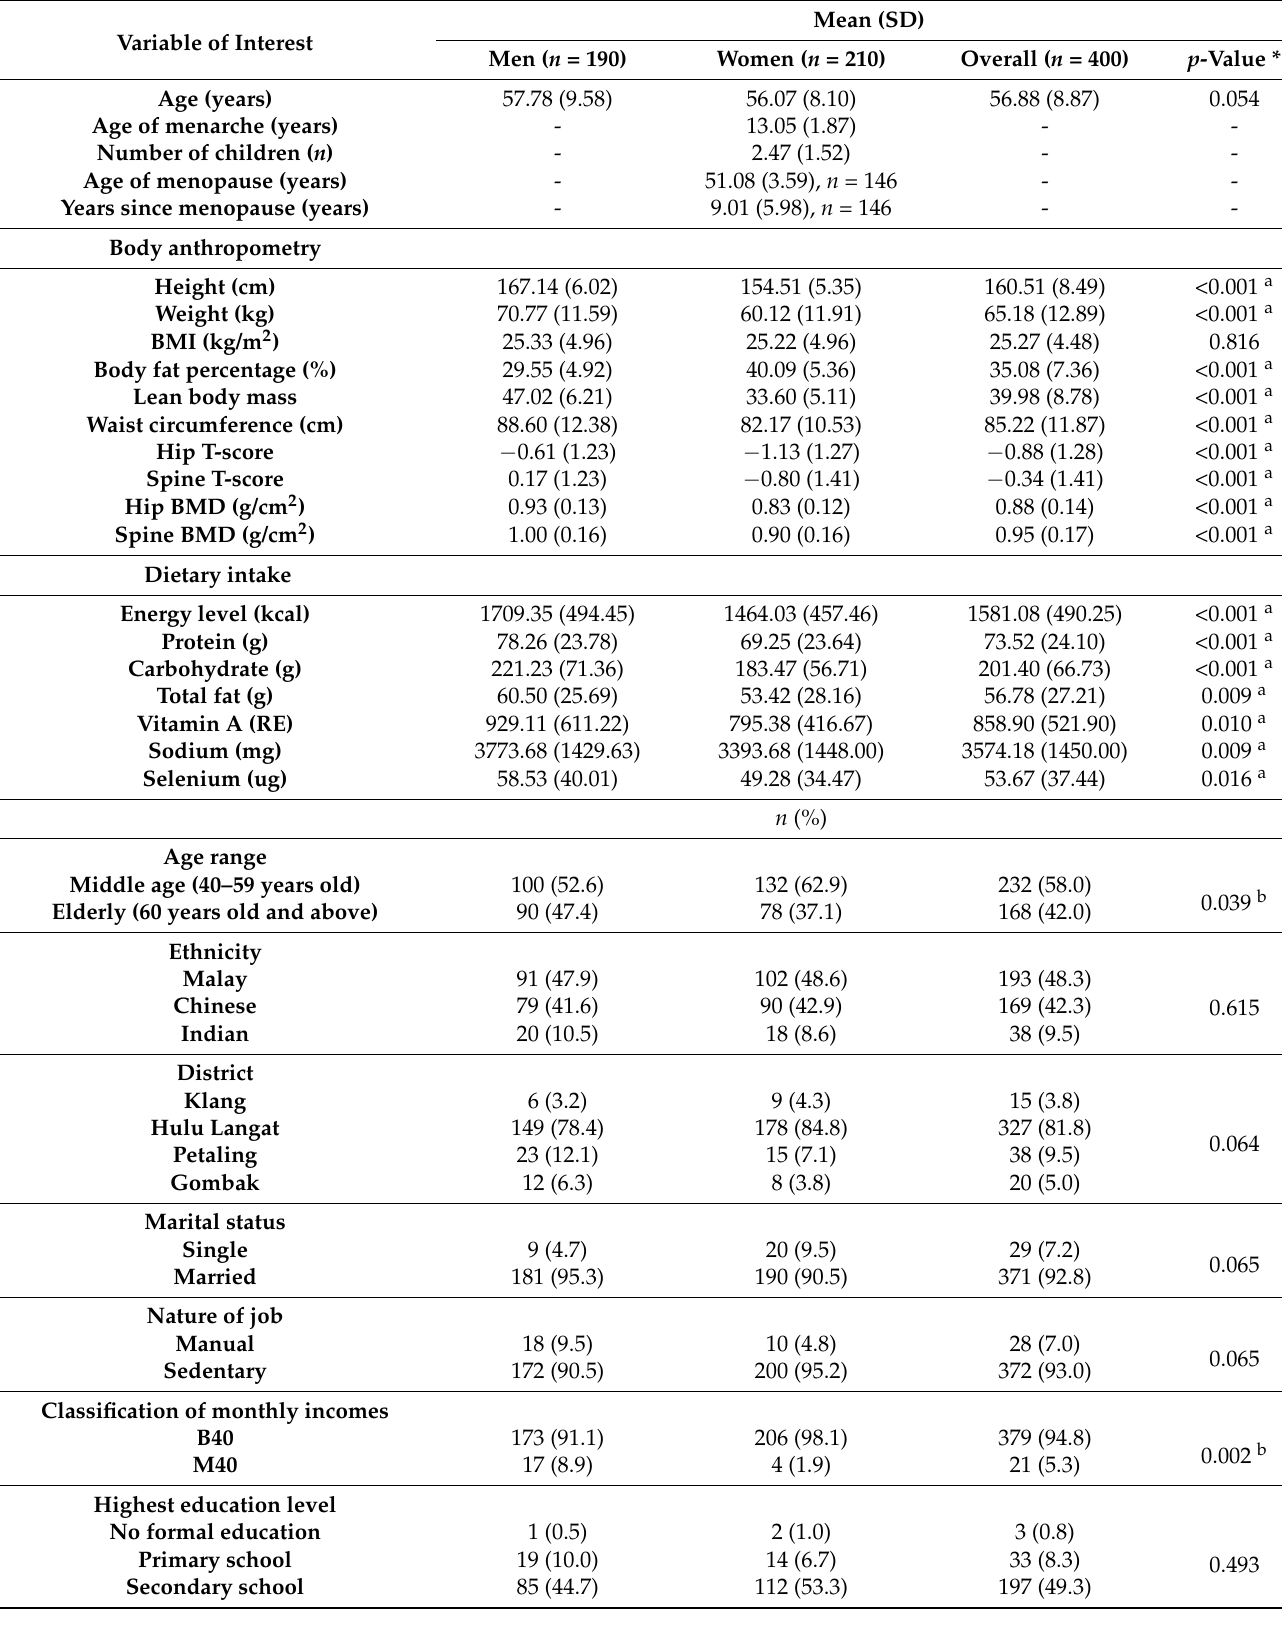
Table 1. Characteristics of subjects in this study during the recruitment